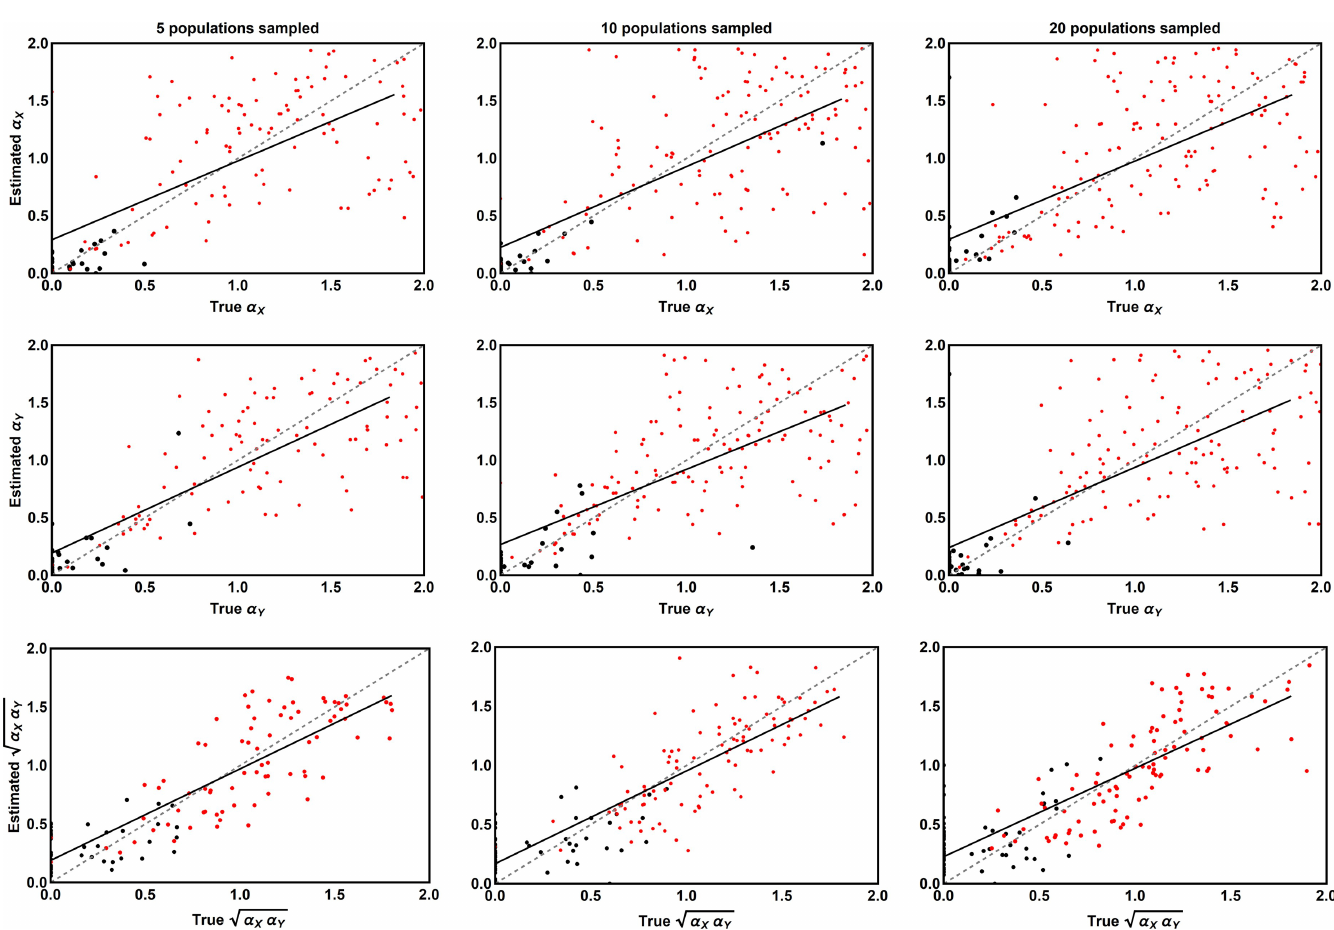
Fig 3. The relationship between the coevolutionary sensitivities used to simulate data (X axis) and the values of these parameters estimated by our ABC method (Y axis) for scenarios where prior distributions for background parameters have been refined using independent estimates. The left-hand column shows results for cases where only 5 populations have been sampled, the center column cases where 10 populations have been sampled, and the right column cases where 20 populations have been sampled. Red points indicate parameter estimates for which the associated credible interval did not include zero. Black points indicate parameter estimates with credible intervals overlapping zero. The solid black line is the best linear fit and the dashed gray line is the perfect one to one relationship expected if all estimates were equal to their true values.